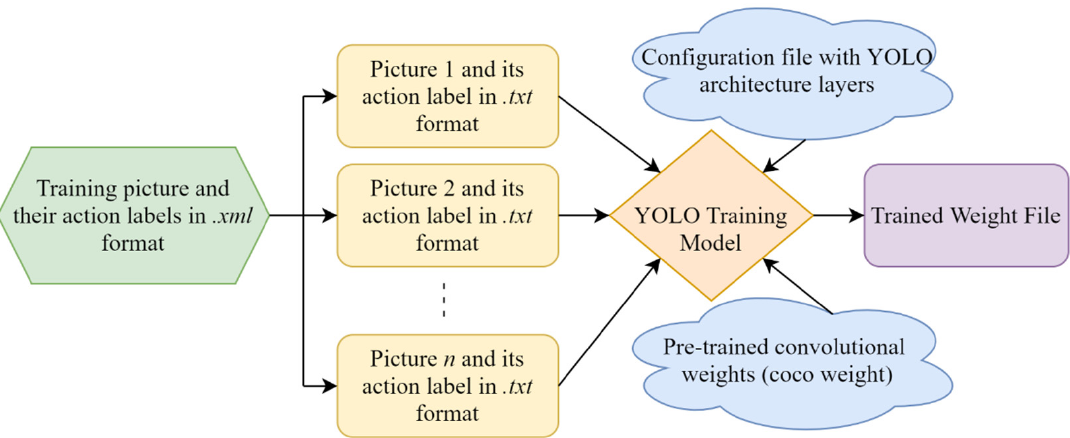
Figure 12. Example of a labeled image.